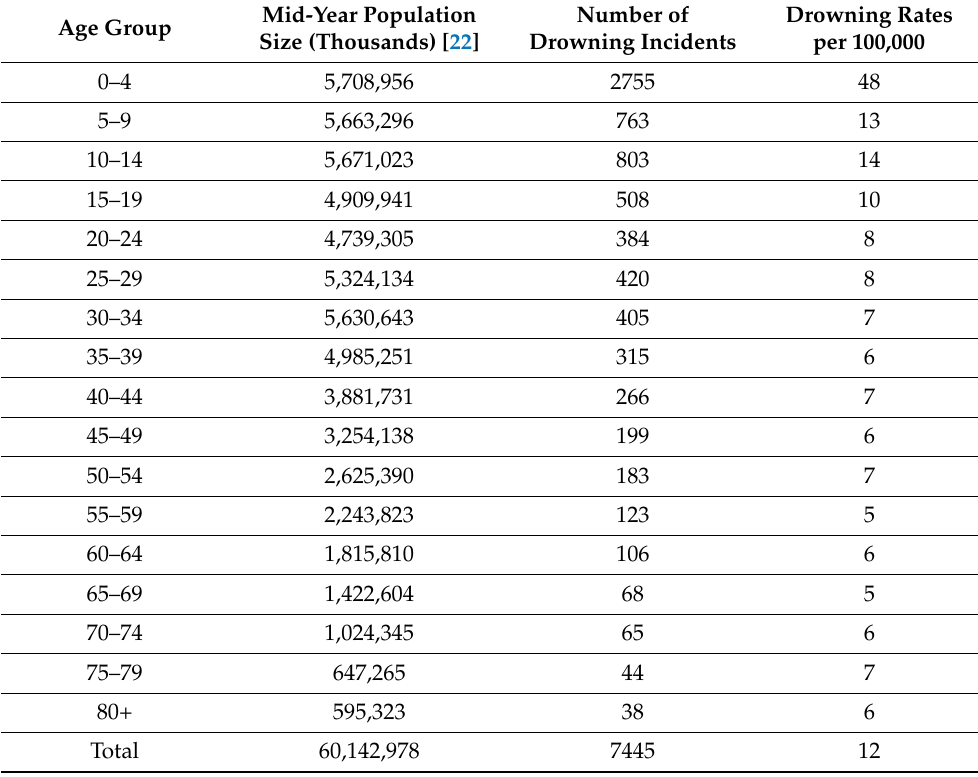
Table 3. Number of drownings per age category in South Africa, 2016–2021.